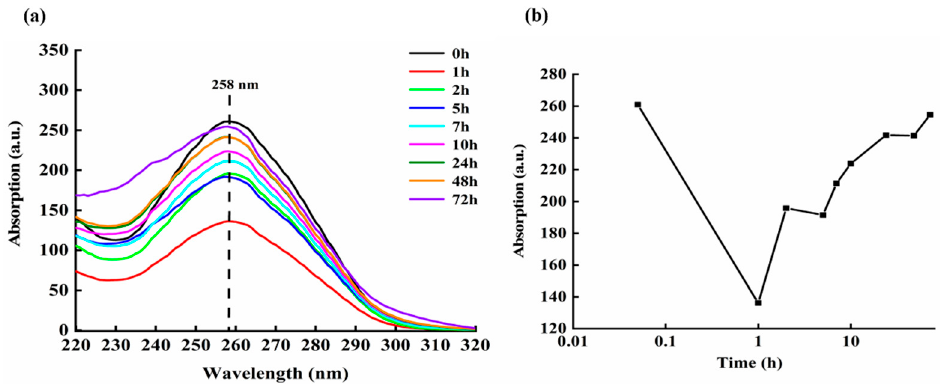
Figure 10. ( a ) Absorption spectra of the DOX-DNA complex with different incubating times; ( b ) absorption peak values of DOX-DNA complex around 258 nm at various incubation times.